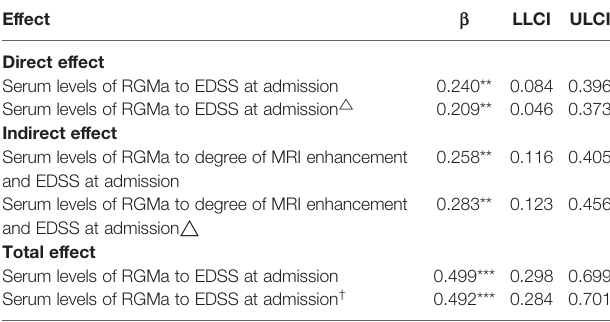
TABLE 5 | The mediating effects of degree of MRI enhancement between serum RGMa level and the EDSS score on admission.